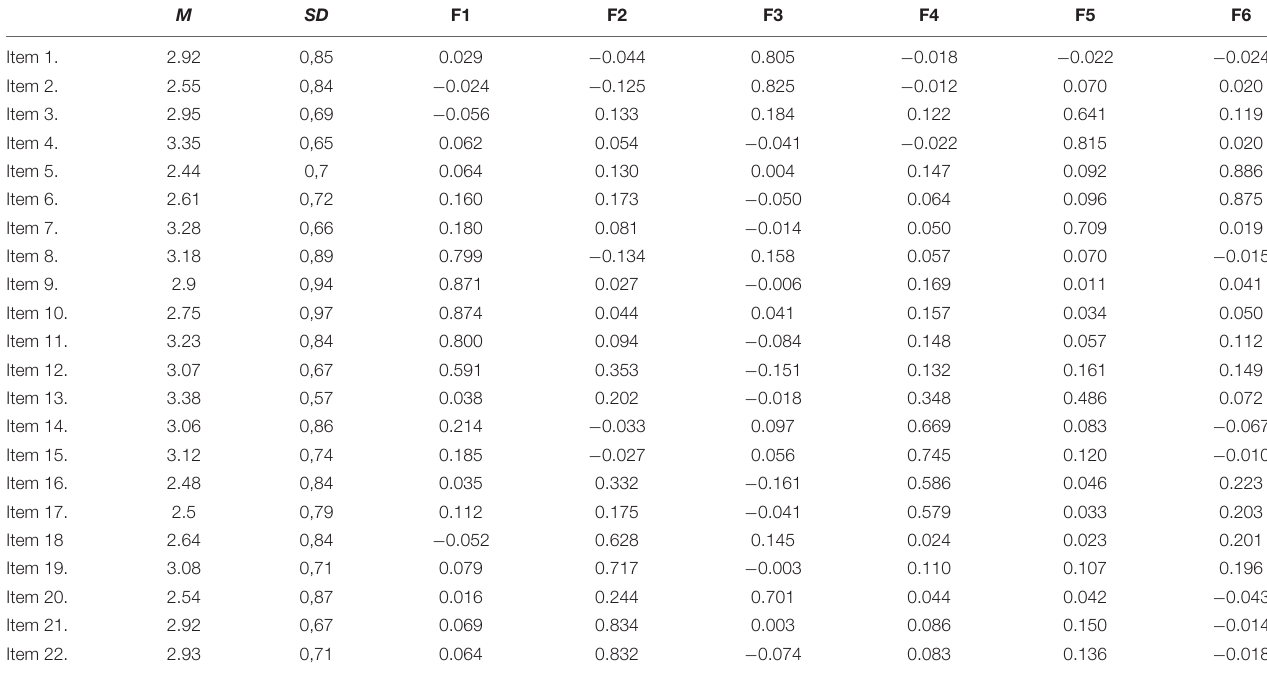
TABLE 2 | Mean, standard deviation, rotated factor matrix, and reliability analysis of variables and factors. M F1